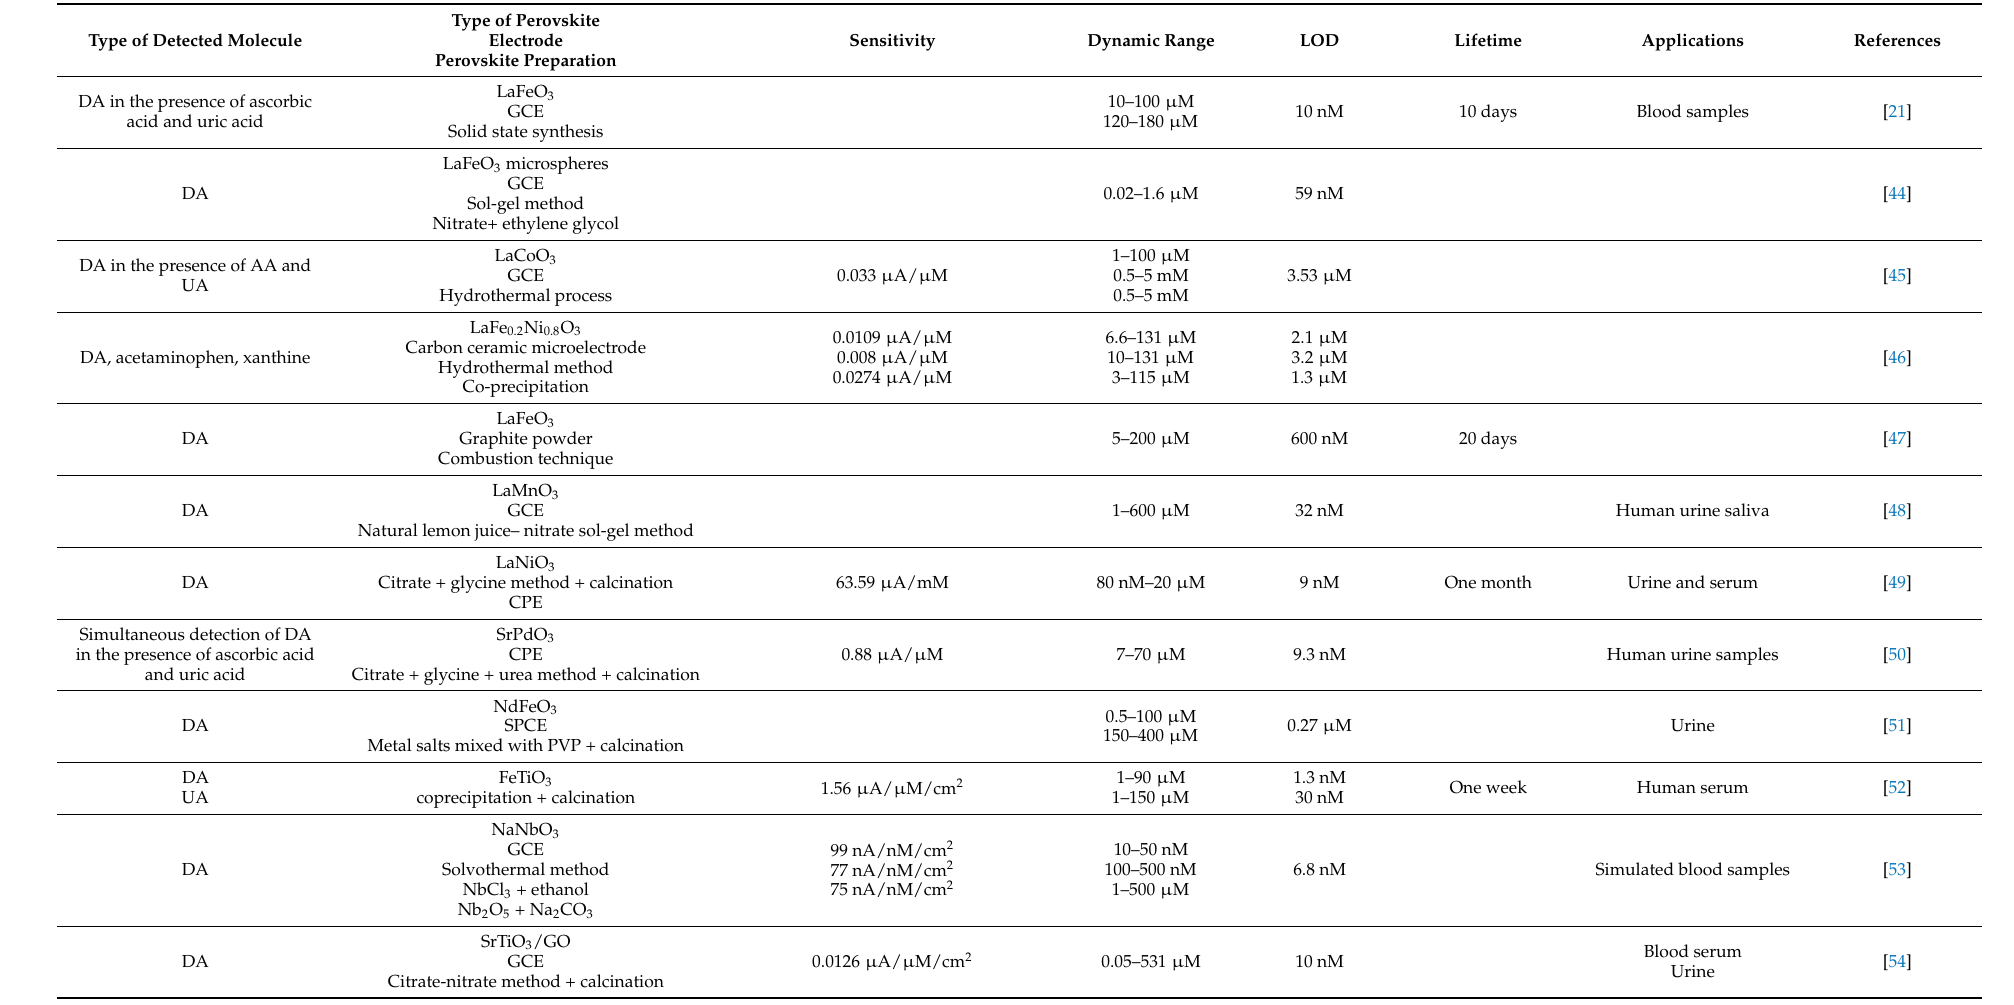
Table 3. Perovskite-based electrochemical sensors for the detection of DA and other bioactive